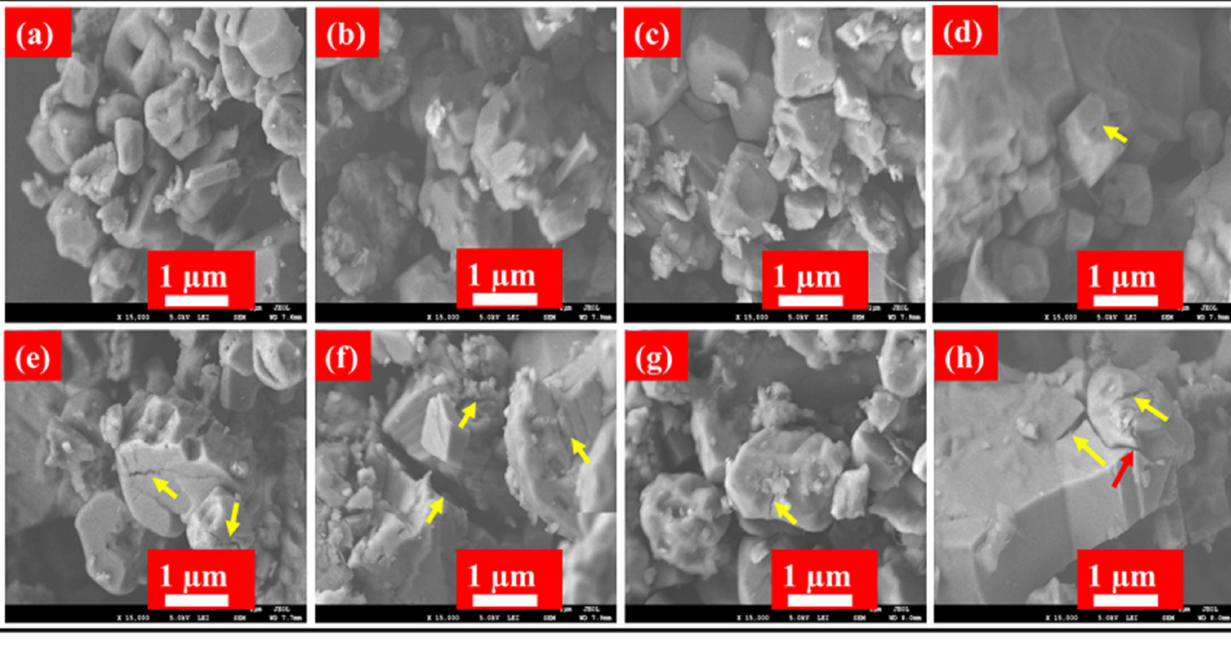
Figure 7. SEM images ( × 15,000, 5 kV) of the untreated and microwave treated (2.45 GHz, 1.7 kW, 4 min) sample S2: ( a – d ): untreated, ( e – h ):